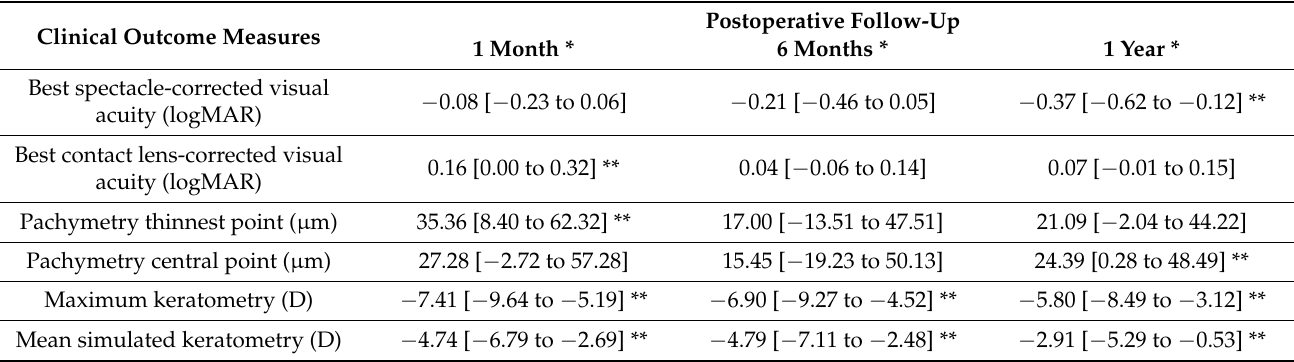
Table 4. Clinical outcome measures during follow-up visits compared with pre-operative values. Clinical Outcome